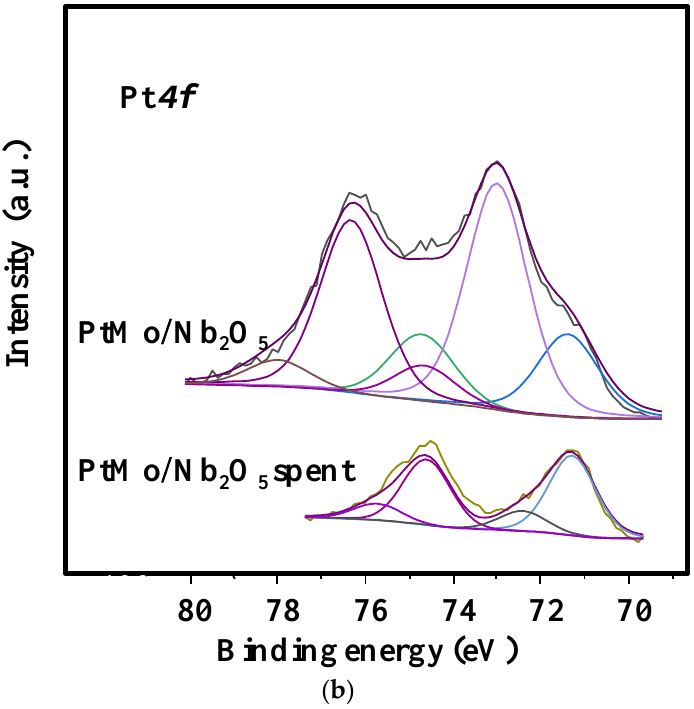
Figure 6. ( a ) Mo 3 d high resolution XPS spectra of fresh CoMo / Nb 2 O 5 and PtMo / Nb 2 O 5 samples and PtMo / Nb 2 O 5 spent catalyst. ( b ) Pt 4 f spectra of both fresh and spent PtMo / Nb 2 O 5 catalysts.